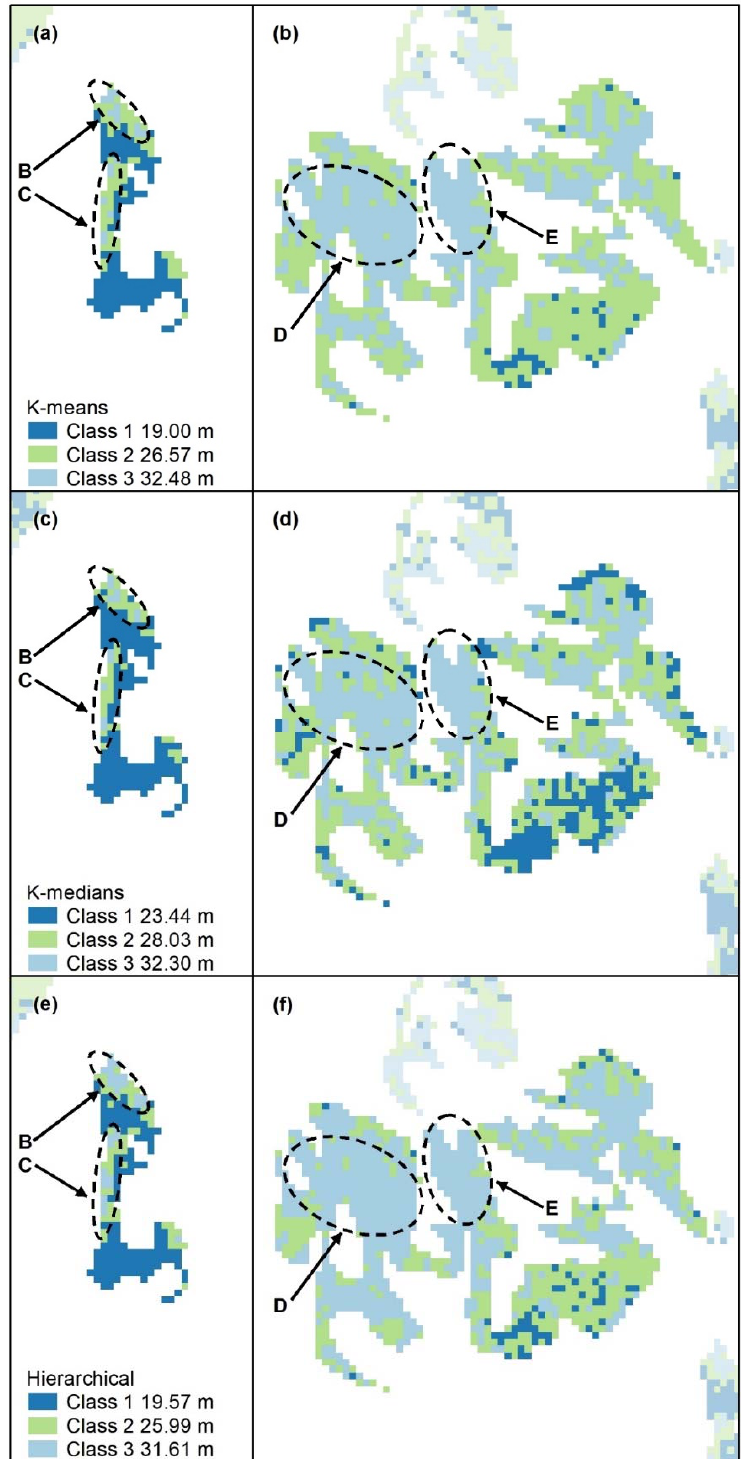
Figure A13. Nonspatial algorithm (K-means, a , b ; K-medians c , d ; hierarchical, e , f ) cluster maps with 3 classes. Letters B–E indicate areas of higher canopy. Features B and C are captured by all algorithms, but D is best captured by K-means ( b ). Panel scores: K-means = 10, K-medians = 10, and Hierarchical = 8.